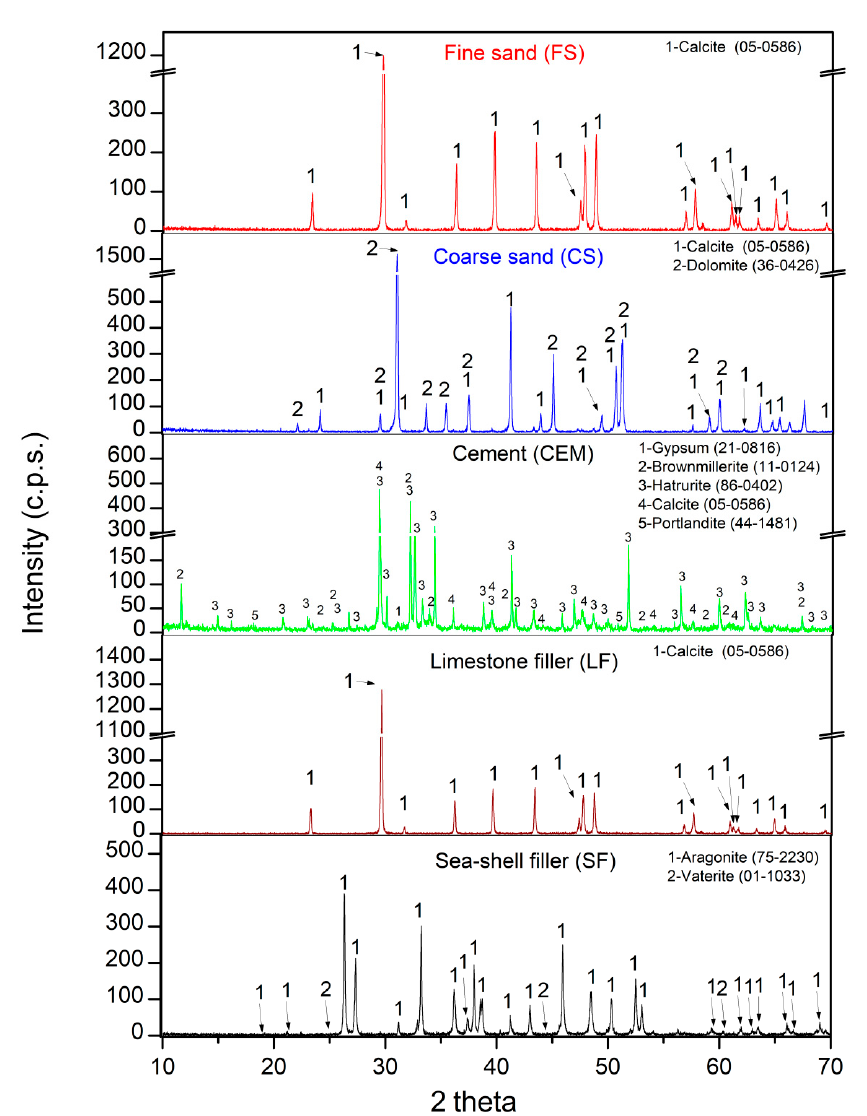
Figure 4. XRD diffraction of Fine sand (FS), Coarse sand (CS), Cement (CEM), Limestone filler (LF) and Seashell filler (SF).